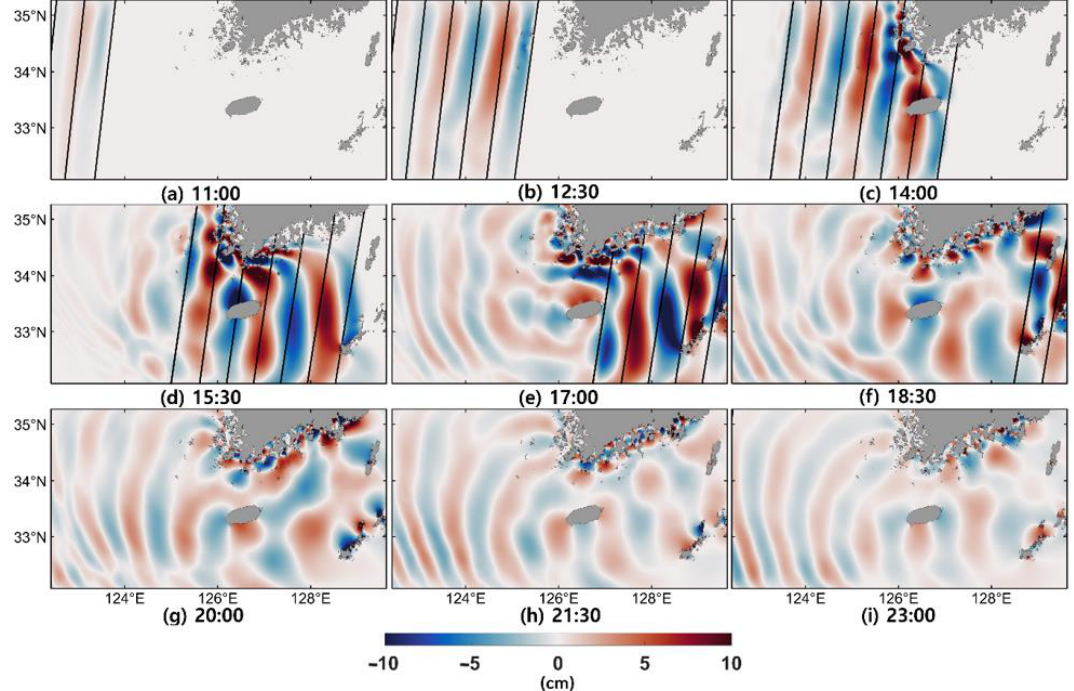
Figure 7. Spatial distribution of modeled sea level elevation (colors) in the Yellow Sea and Korea Strait every 1.5 h from 11:00 to 23:00 on 7 April 2019. Colors represent sea level anomalies. Black straight lines represent 1024 hPa isobars in atmospheric pressure that propagate eastward (Figure 5).